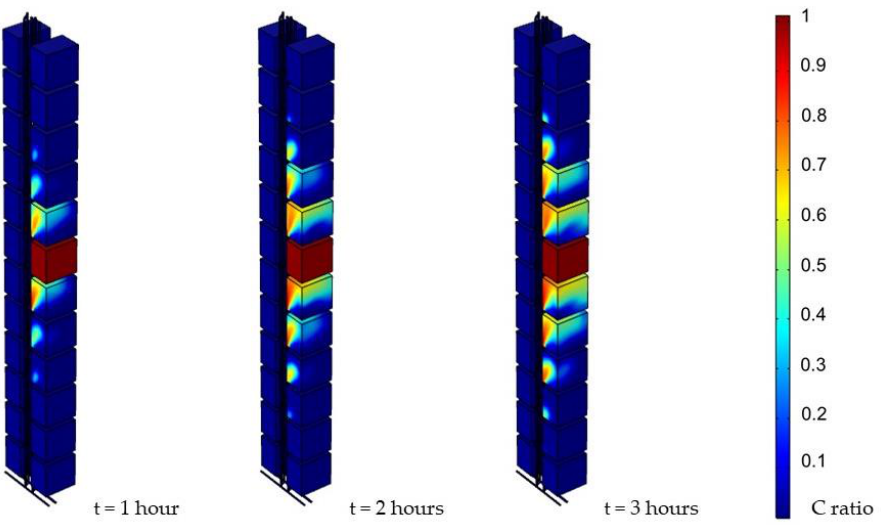
Figure 7. Simulation results of first three hours (0.05 Pa, 1000 ppm).